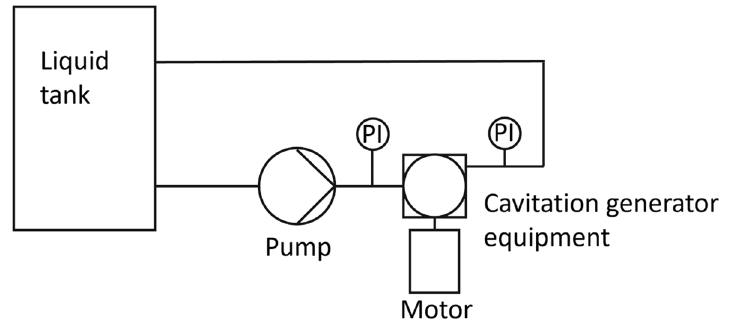
Figure 1. Schematic illustration of the water treatment system.